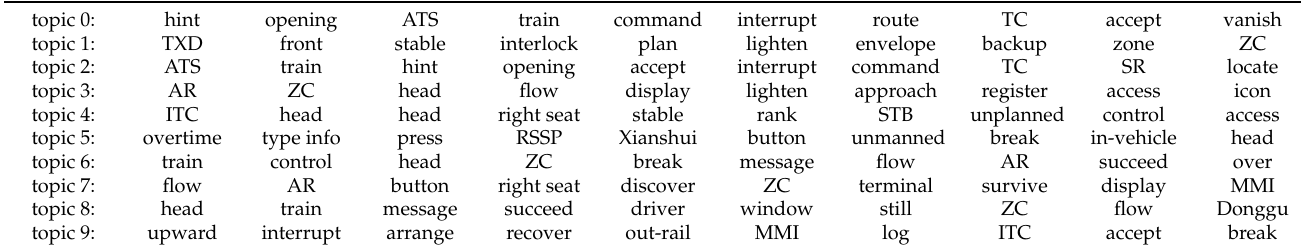
Table 5. Topic analysis of automatic end change (AEC).